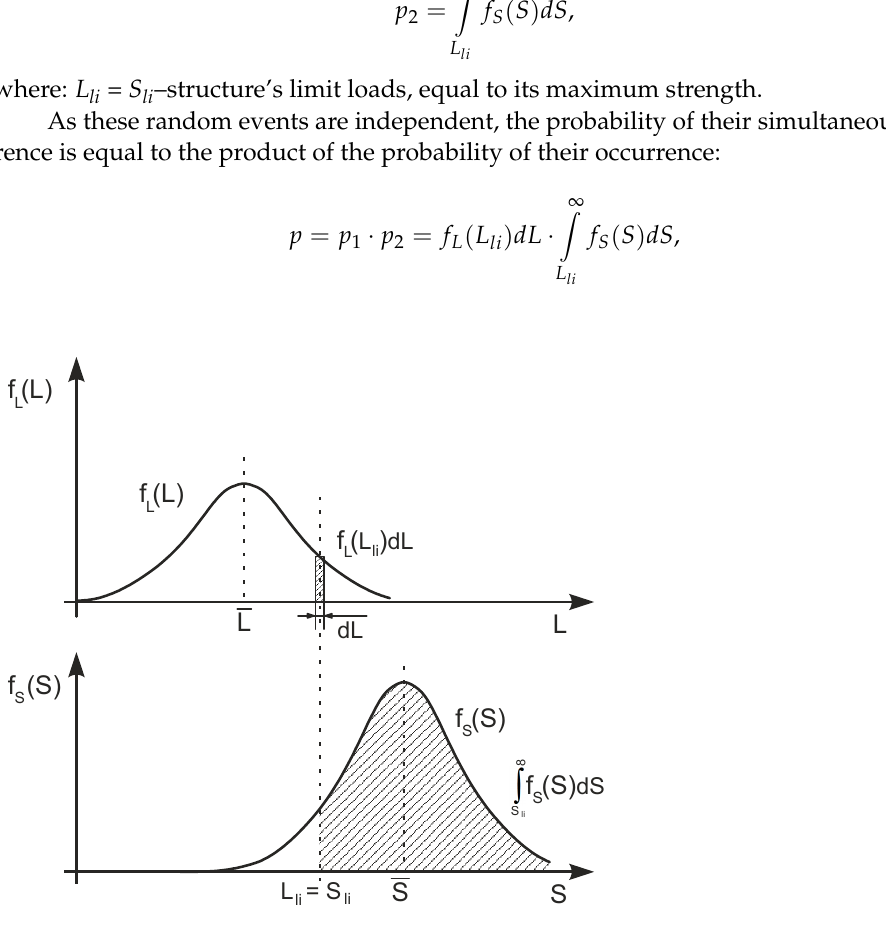
Figure 4. Graphical representation of the simultaneous occurrence of two independent events, i.e.,: a structure’s load of L li and a structure’s strength greater than or equal to S li = L li .